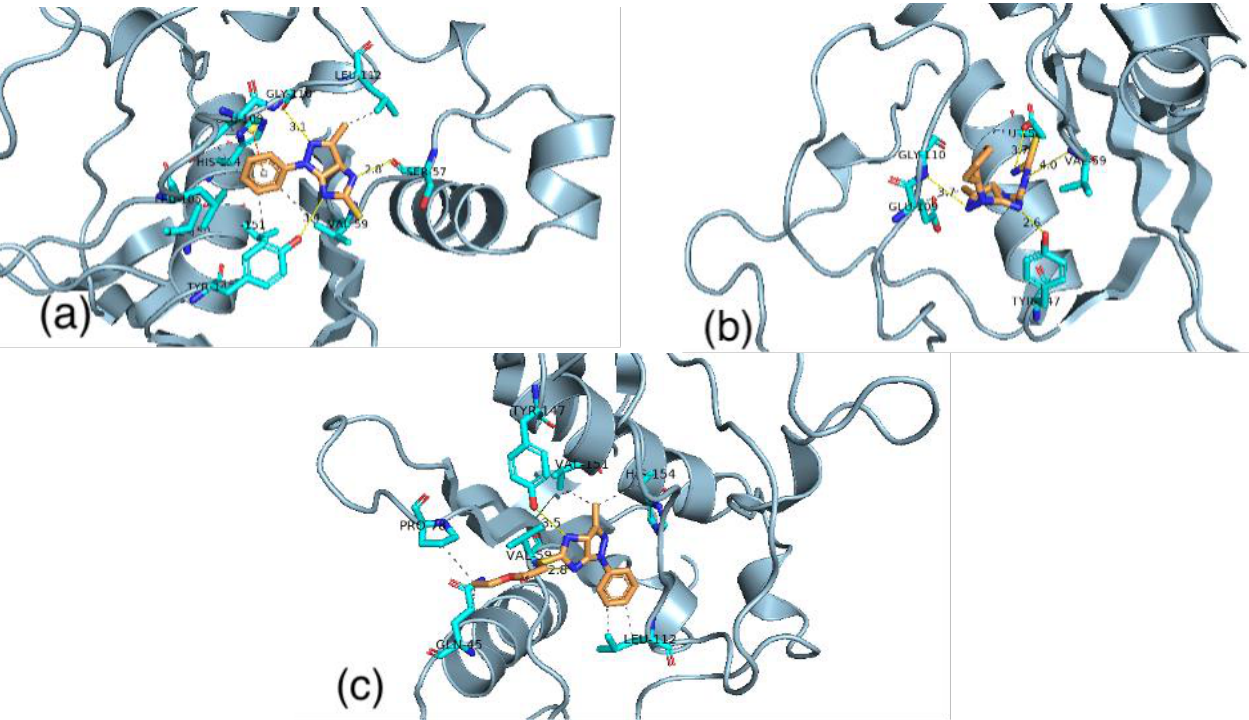
Figure 7. The binding of ligand ( 1 ) ( a ) ligand ( 2 ) ( b ) and ligand ( 3 ) ( c ) with the active site of Staphylococcus aureus.